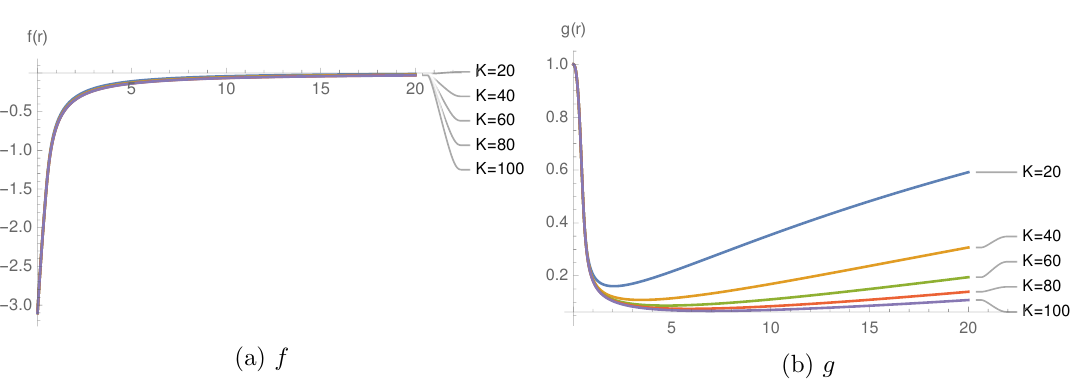
Figure 9. The pro(cid:12)le functions f and g for the Skyrme-instanton minimiser of E 0 on the (cid:12)nite intervals [0 : 01 ; K ], for K = 20 ; 40 ; 60 ; 80 ;